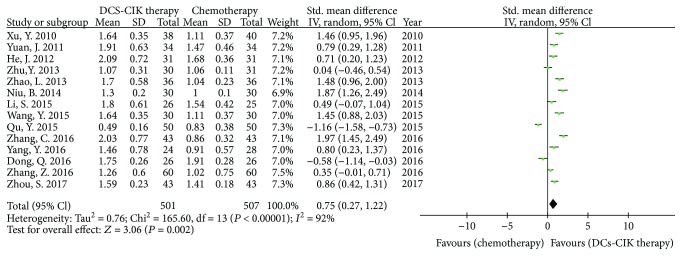
The analysis of CD4+/CD8+ T cells between the two groups.